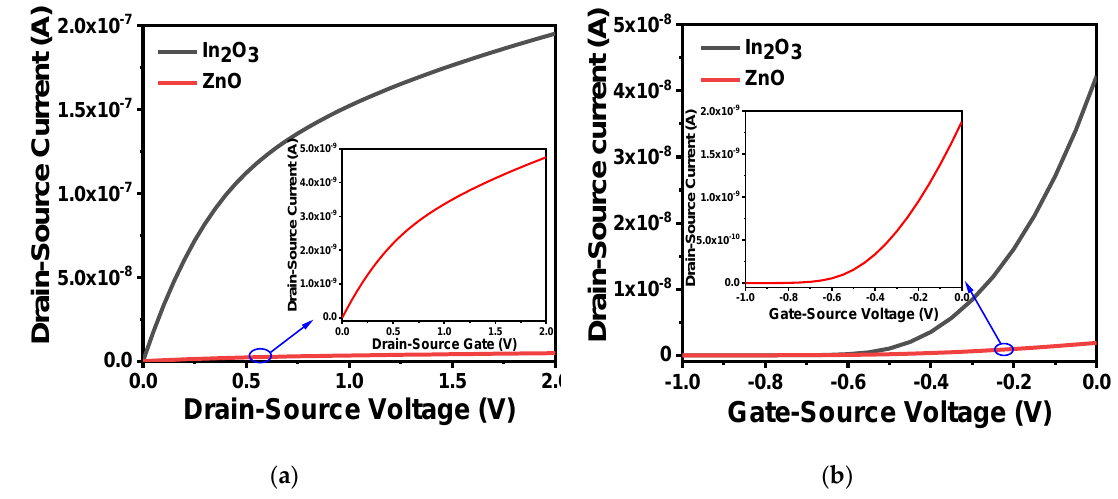
Figure 4. Characteristics of different channel materials: ( a ) output characteristic curve of different channel materials in 𝑉 𝐺𝑆 = 0.5 V ; ( b ) transfer characteristic curve of different channel materials at 𝑉 𝐷𝑆 = 2.5 V .